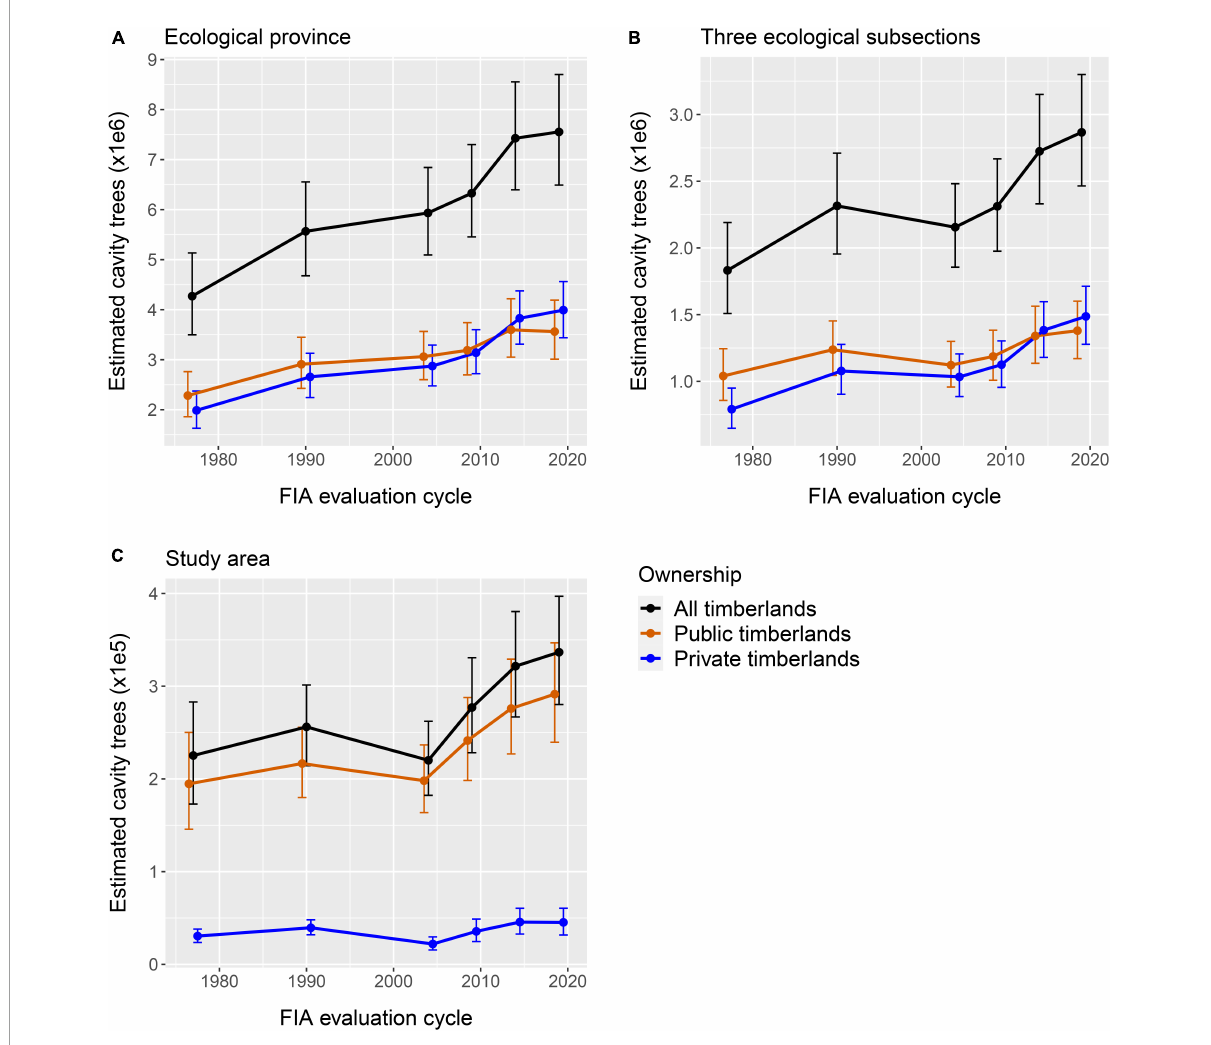
FIGURE2 (A–C) The three spatial scales in MN, United States in which the abundance of stems with cavities suitable for nesting wood ducks was estimated using tree-cavity data from and Forest Inventory and Analysis data. (A) Is the study area in which cavity data were collected, (B) is the three ecological subsections the intersect with the study area, and (C) is the ecological province in which the study area occurred.